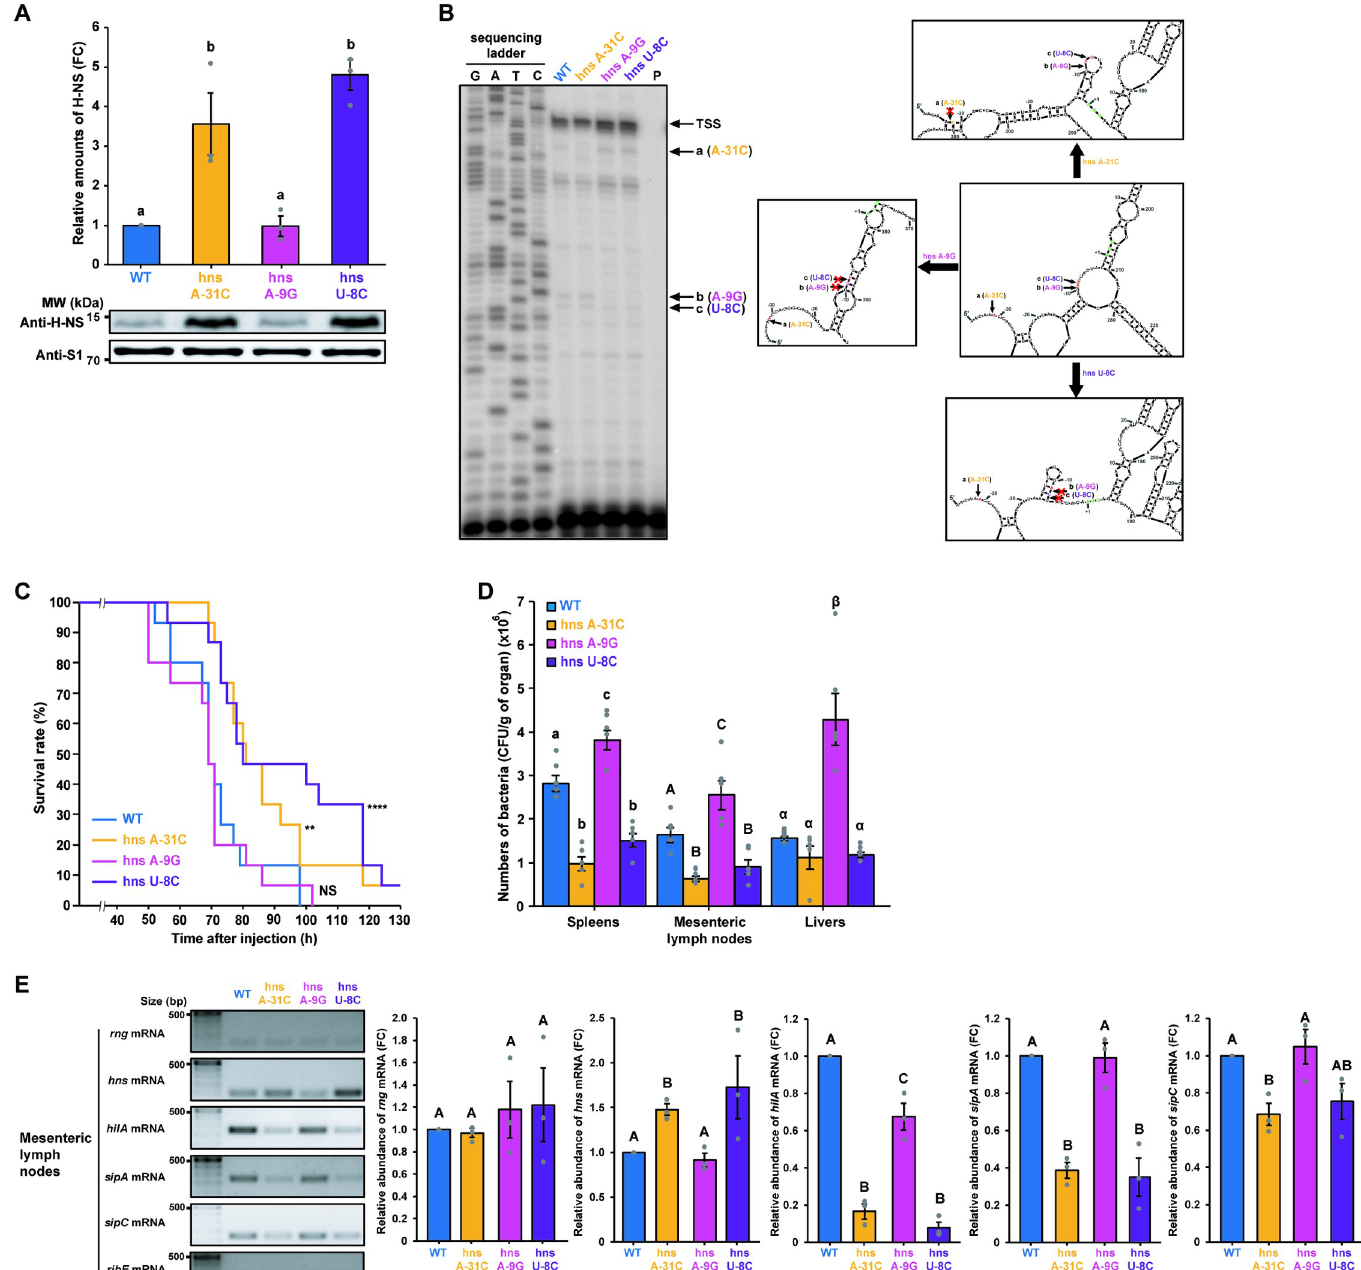
Fig 5. Effects of nucleotide substitutions in the RNase G cleavage sites of the hns mRNA 5 0 UTR on hns expression. (A) Western blot analysis of H-NS in S . Typhimurium strains (WT, hns A-31C, hns A-9G, and hns U-8C). WT H-NS levels were set to 1. Ribosomal protein S1 was used as an internal standard. (B) Primer extension analysis of hns mRNA 5 0 UTR containing the wild-type or mutated sequence (hns A-31C, hns A-9G, or hns U-8C) in vivo . Left: Total RNA samples isolated from the S . Typhimurium cultures used in (A) were analyzed. Sequencing ladders were synthesized with the same primer used in cDNA synthesis and PCR DNA encompassing the hns gene as a template. Right: The secondary structure of the full-length hns sequence containing the wild-type or mutated sequence (hns A-31C, hns A- 9G, or hns U-8C) was deduced using the M-Fold program. Representative structures of the 5 0 UTR that most frequently occur when the mutated sequences are used to deduce the secondary structure of full-length hns mRNA. Arrows indicate RNase G cleavage sites. Start codon is indicated by bold, green characters. TSS; transcription start site. (C) Survival rates and duration of BALB/c mice ( n = 15 per group) infected with S . Typhimurium. strains (WT, hns A-31C, hns A-9G, and hns U-8C). Survival was monitored for 7 days. �� P < 0.01 and ���� P < 0.0001 for hns A-31C-, hns A-9G-, or hns U-8C-infected mice vs. WT-infected mice (two-sided unpaired Student’s t - test). (D) Colonization assay for S . Typhimurium. BALB/c mice ( n = 5 per group) intraperitoneally infected with S . Typhimurium strains (WT, hns A-31C, hns A-9G, and hns U-8C). Data represent the mean ± s. e. m. of at least three independent experiments. Statistically significant differences from one-way ANOVA with Student-